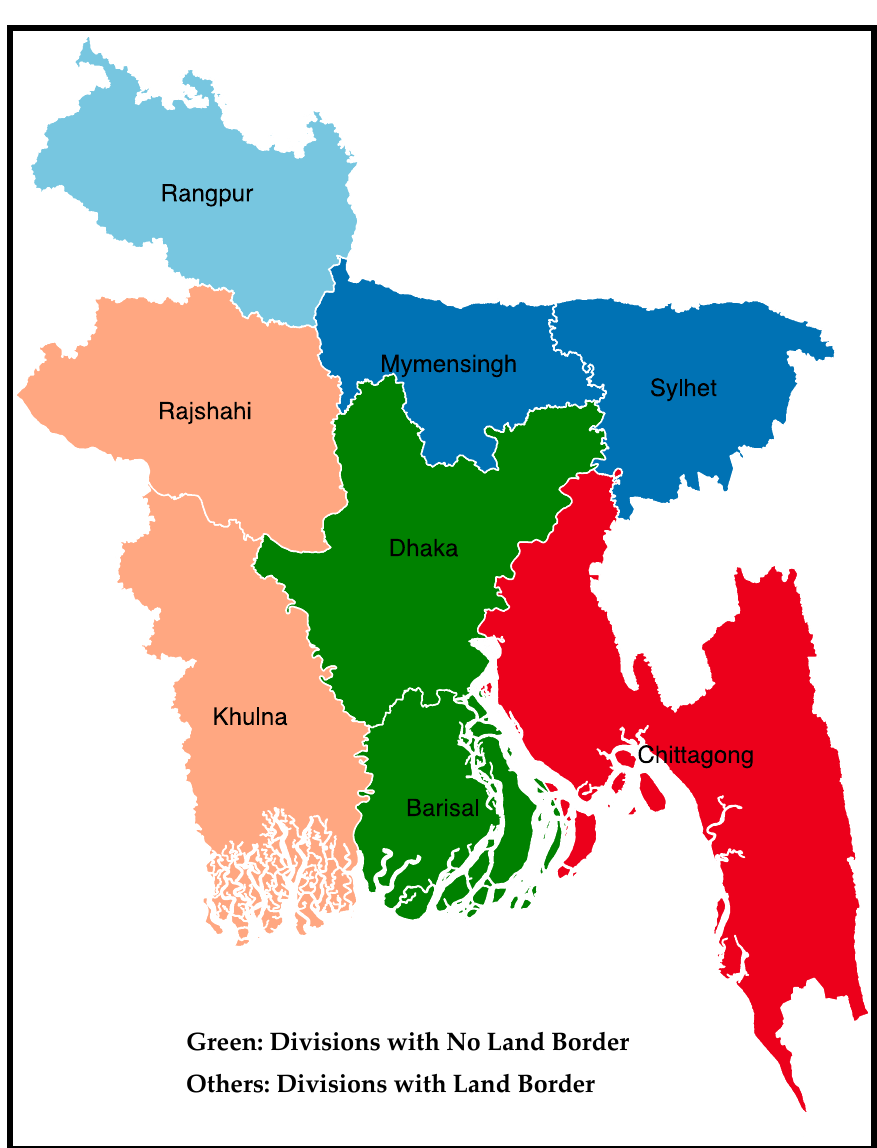
Figure A1. Bangladesh—divisional status with regards to border.